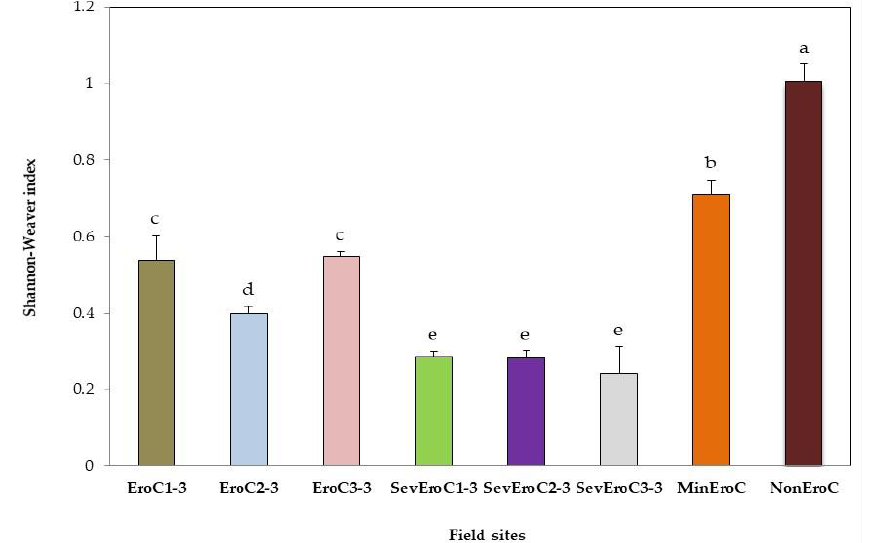
Figure 3. AMF diversity (Shannon–Weaver index) in field sites with different erosion degrees. Each column color indicates a different field site with coffee. Columns with the same letter are not significantly different according to the post hoc LSD Fisher test at p < 0.05.